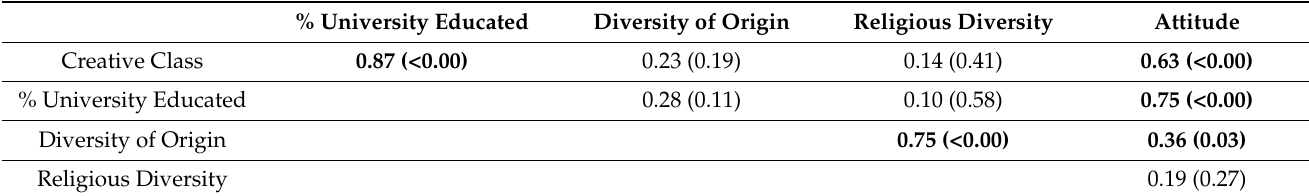
Table 6. Pearson correlation coefficients between the five variables that make up the Diversity and Creativity Indices. % University Educated Diversity of Origin